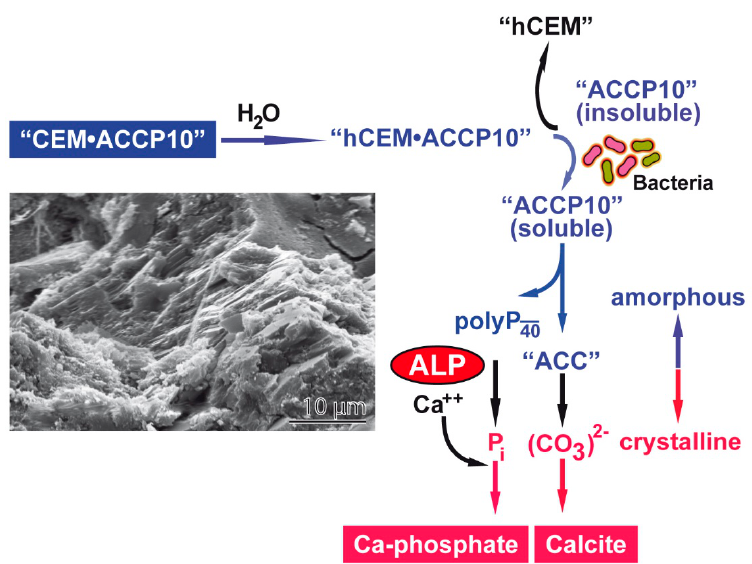
Figure 14. Schematic illustration of the reaction proceeding in the “ACCP10”-supplemented cement, “hCEM • ACCP10”, via formation of amorphous calcium carbonate and amorphous polyP to crystalline Ca-phosphate and crystalline Ca-carbonate (SEM image as insertion). The transition of the amorphous “ACCP10” in “hCEM • ACCP10” occurs after rendering “ACCP10” to a soluble phase. Subsequently, the bacterial alkaline phosphatase (ALP) enzymatically disintegrates the “ACCP10” particles to Ca 2 + and P i and initiates the process of crystal formation of Ca-phosphate and